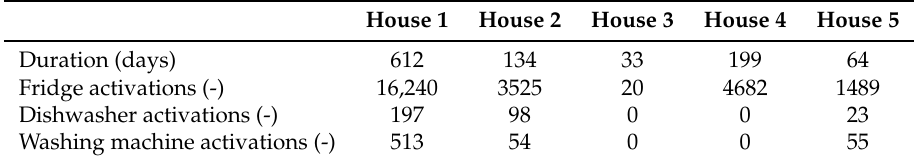
Table 1. Duration of measurements and number of appliance activations in UK-DALE dataset houses. House 1 House